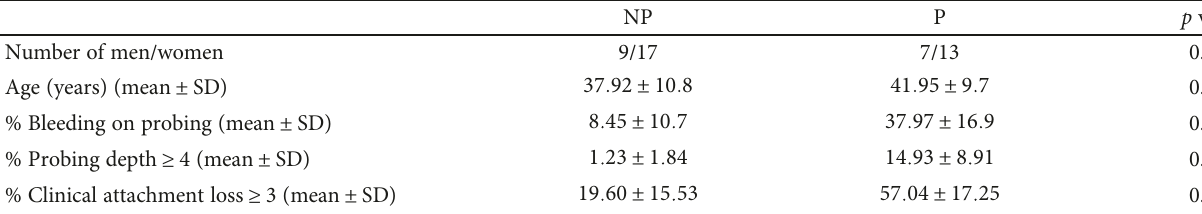
SD = standard deviation, p = significance level ( p ≤ 0 05 ).